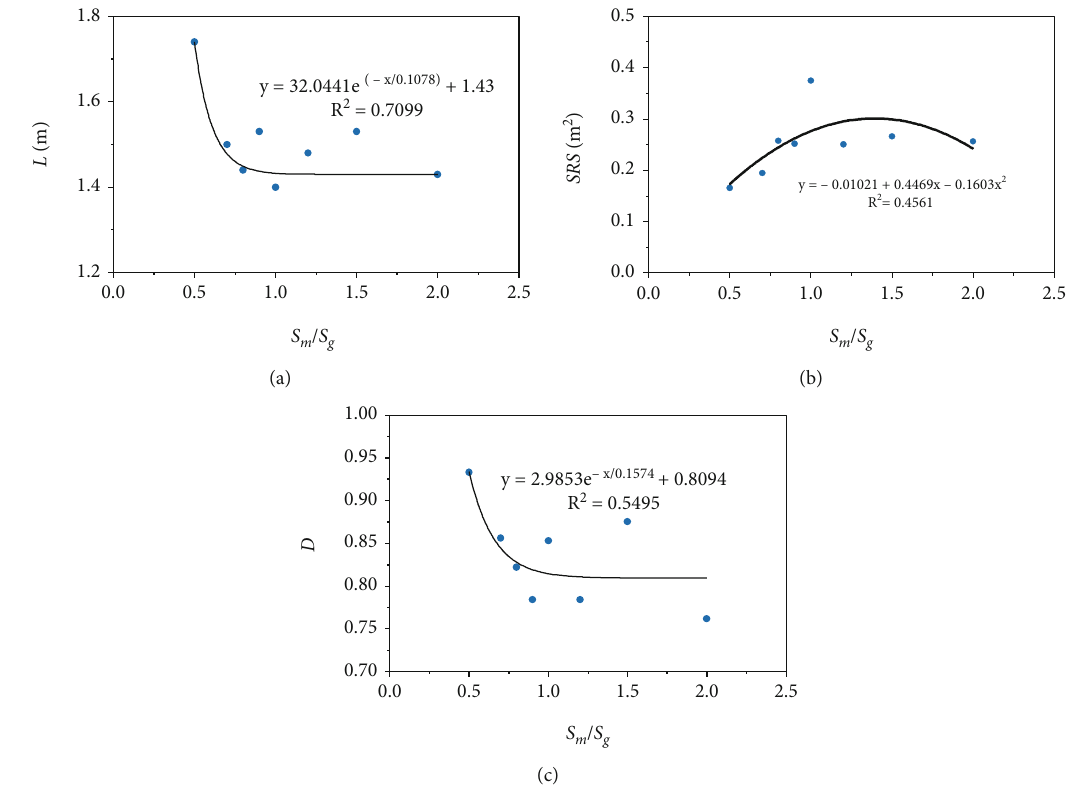
Figure 14: Geometric parameters of HF under di ff erent ratios of the shear strength of the matrix to